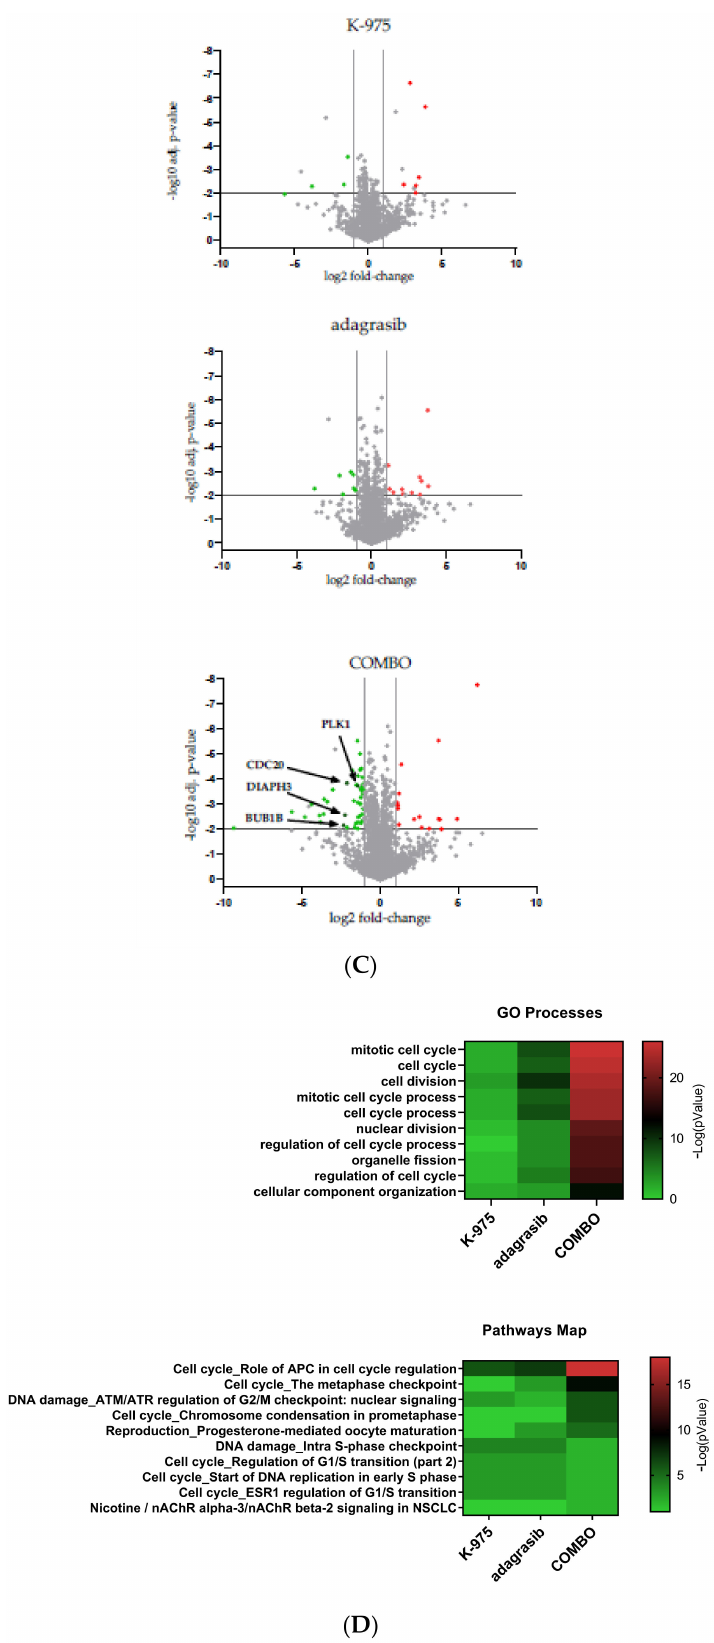
Figure 3. Transcriptomic and proteomic approaches show regulation in G1/S and G2/M transition checkpoints for the combined treatment of adagrasib and K-975. ( A ) Schematic representation